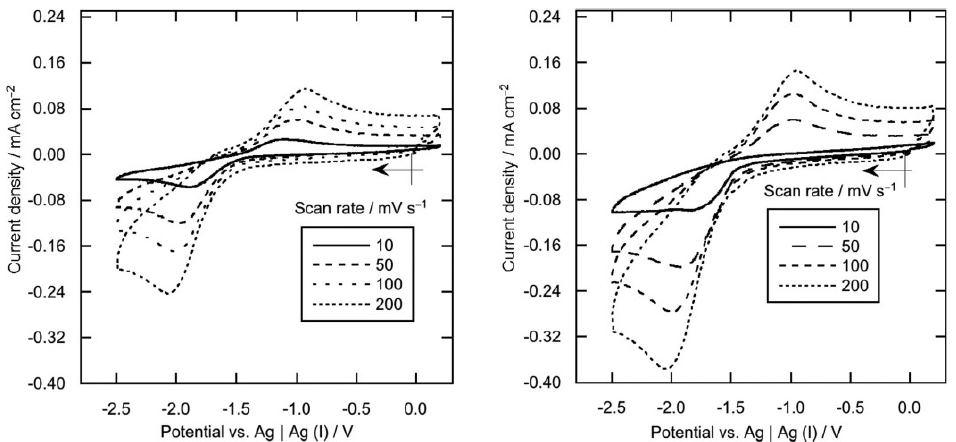
Figure 15. Cyclic voltammetry of [Sm(NTf 2 ) 3 ] (10 mM) in [bmpy][NTf 2 ] at a glassy-carbon electrode at various scan rates, 25 ◦ C ( left ) and 100 ◦ C ( right ). Reproduced with permission from [67], at various scan rates, 25 °C ( left ) and 100 °C ( right ). Reproduced with permission from [67], copyright copyright 2019, 2019, ECS.